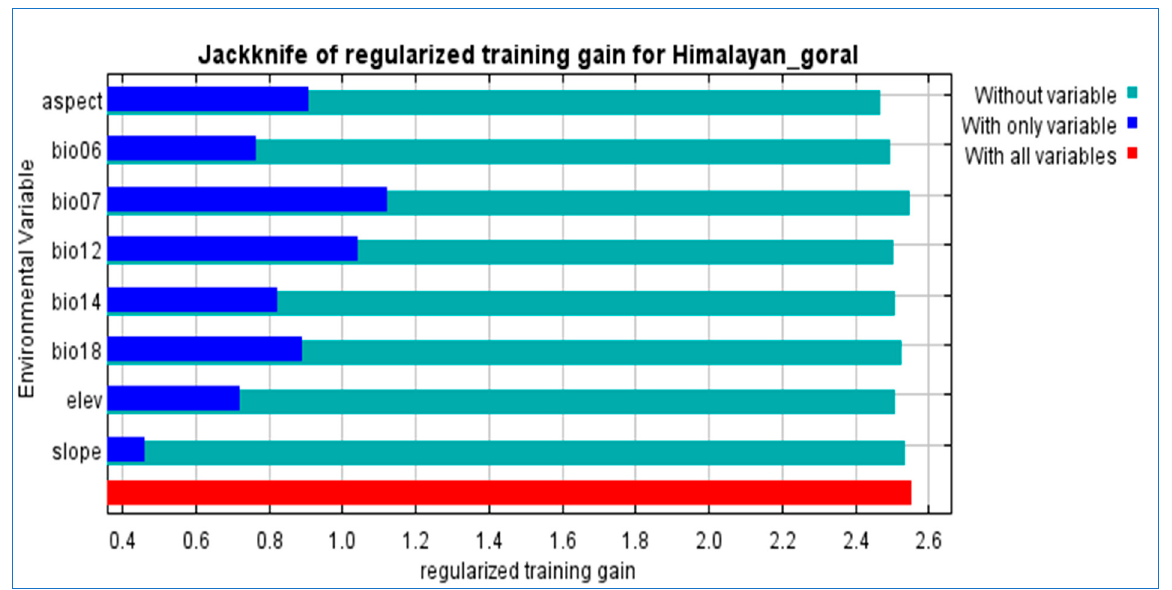
Figure 4. MaxEnt model for Himalayan goral using the jackknife of regularized training gain to determine the predictive strength of environmental variables.